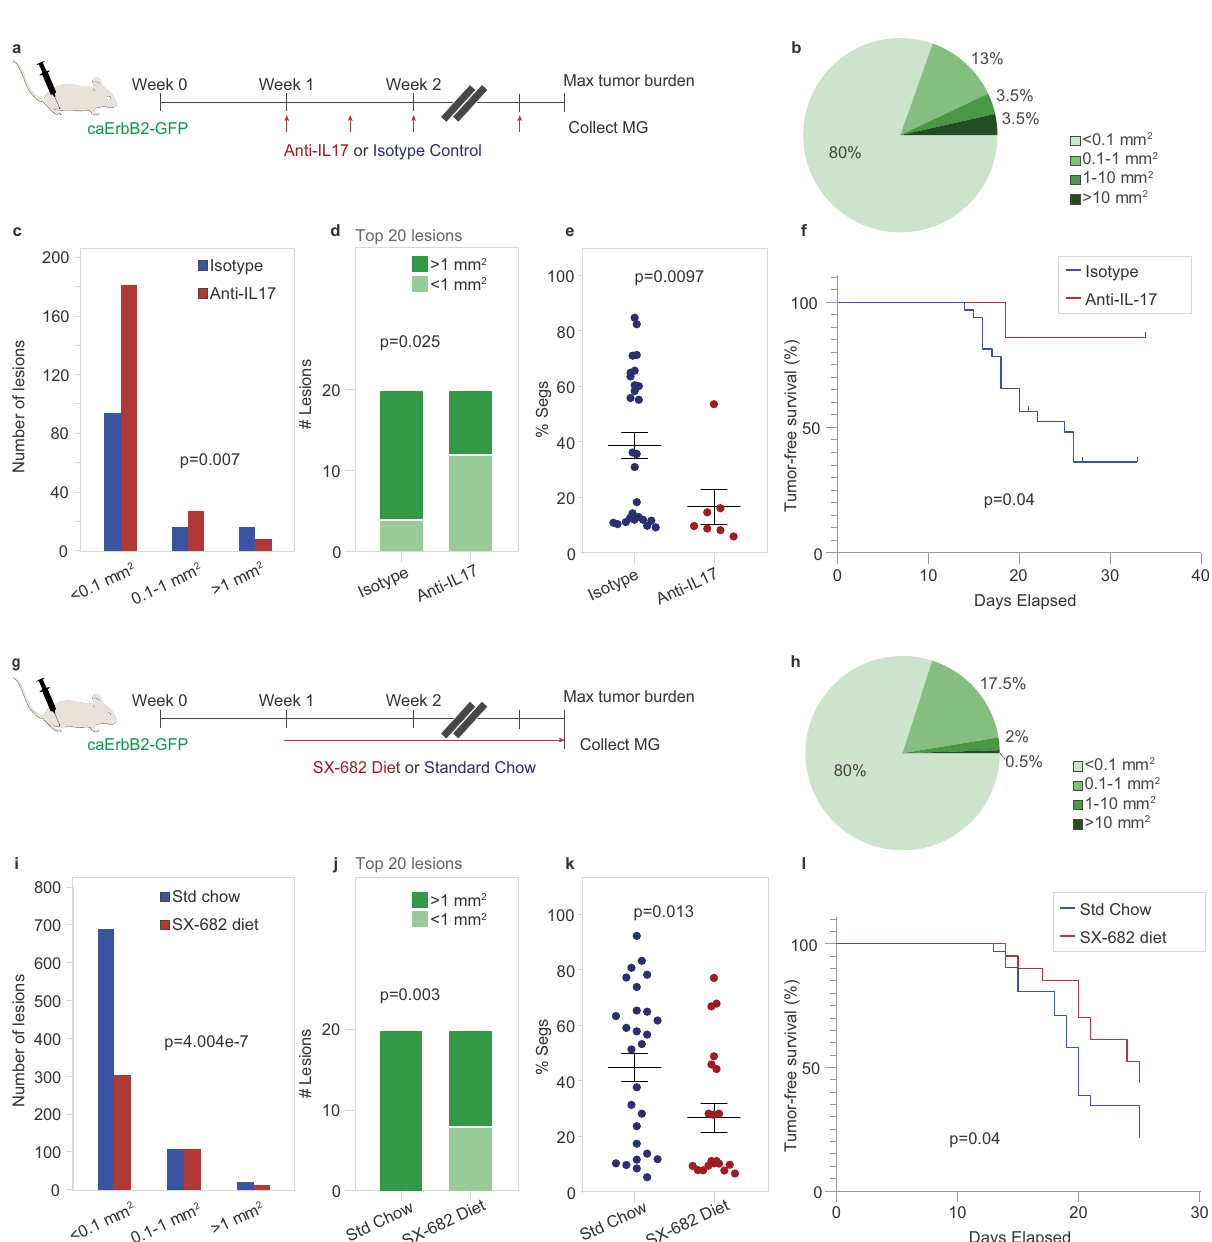
Fig. 7 Inhibition of IL-17 and granulocyte recruitment reduces aggressive niche formation and delays tumor progression. Animals were treated with anti-IL-17/17RA or isotype control ( a – f ), and SX-682 diet or standard chow ( g – l ). a , g Schema showing experimental timeline: animals were allowed to form lesions for 1 week then treated until endpoint. All animals were collected when any one animal reached maximum tumor burden. Quanti fi cation of lesion area from animals treated with anti-IL-17/17RA or isotype control ( b – d ), treated in the same cohort, and SX-682 diet or standard chow ( h – j ), treated in the same cohort. Only mammary glands bearing lesions could be quanti fi ed. Anti-IL-17 study, n = 5 per group; SX-682 study, n = 8 per group. Pie chart showing proportion of lesions by size for Anti-IL-17 study ( b ) and SX-682 study ( h ). c , i Quanti fi cation of lesion area and number binned by size, with p value calculated by Pearson ’ s Chi-squared test, for Anti-IL-17 study (Chi-squared ( χ 2 ) = 10.014, df = 2) ( c ) and SX-682 study (Chi-squared = 29.462, df = 2) ( i ). d , j Stacked column graph of 20 largest lesions per group binned by size for anti-IL-17 study ( d ) and SX-682 study ( i ). P value calculated by two- sided Fisher ’ s exact test. e , k Percent segmented cells measured by complete blood count from peripheral blood collected at time of euthanasia and mammary gland collection. P value was calculated using two-sided Wilcoxon rank sum test; error bars indicate standard error of the mean (SEM). Each dot represents one animal. e Anti-IL-17 group, n = 7; control group, n = 32 pooled from multiple identically treated control cohorts; U = 43. k SX-682 group, n = 20; control group, n = 29 pooled from multiple identically treated cohorts, U = 169.5. f , l Kaplan – Meier plot showing tumor-free survival curves of treated animals. Two-sided p value calculated using log-rank (Mantel – Cox) test. f Anti-IL-17 group, n = 7; control group, n = 32 pooled from multiple identically treated cohorts. l SX-682 group, n = 20; control group, n = 29 pooled from multiple identically treated cohorts. Source data are provided as a Source Data fi